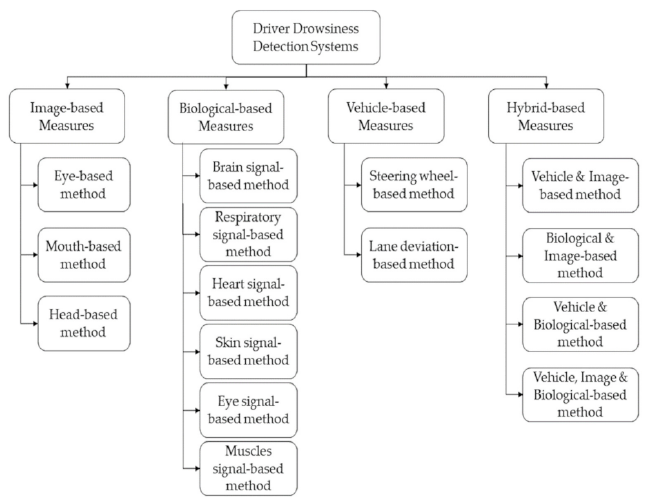
Figure 1. Driver drowsiness detection measures.